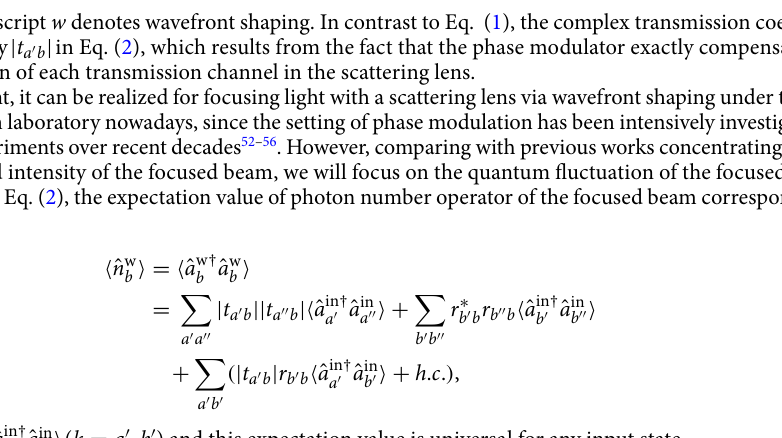
Figure 2. Quantized light propagating through a scattering lens ( a ) in the absence of wavefront shaping, ( b ) a in a in in the presence of wavefront shaping. a ′ ( ˆ b ′ ) represents the annihilation operator of the input mode and ˆ ˆ a b ) the output mode. When the beams are injected, without the wavefront shaping in ( a ), the scattering lens ( ˆ separates the light into different optical channels randomly. As a result, the output presents a speckle pattern. In ( b ), with the wavefront shaping, the scattering lens couples the beams into the desired optical paths. Hence the output presents an ordered pattern. The wavefront shaping, performed by a spatial light modulator in ( b ), controls the phase of incident